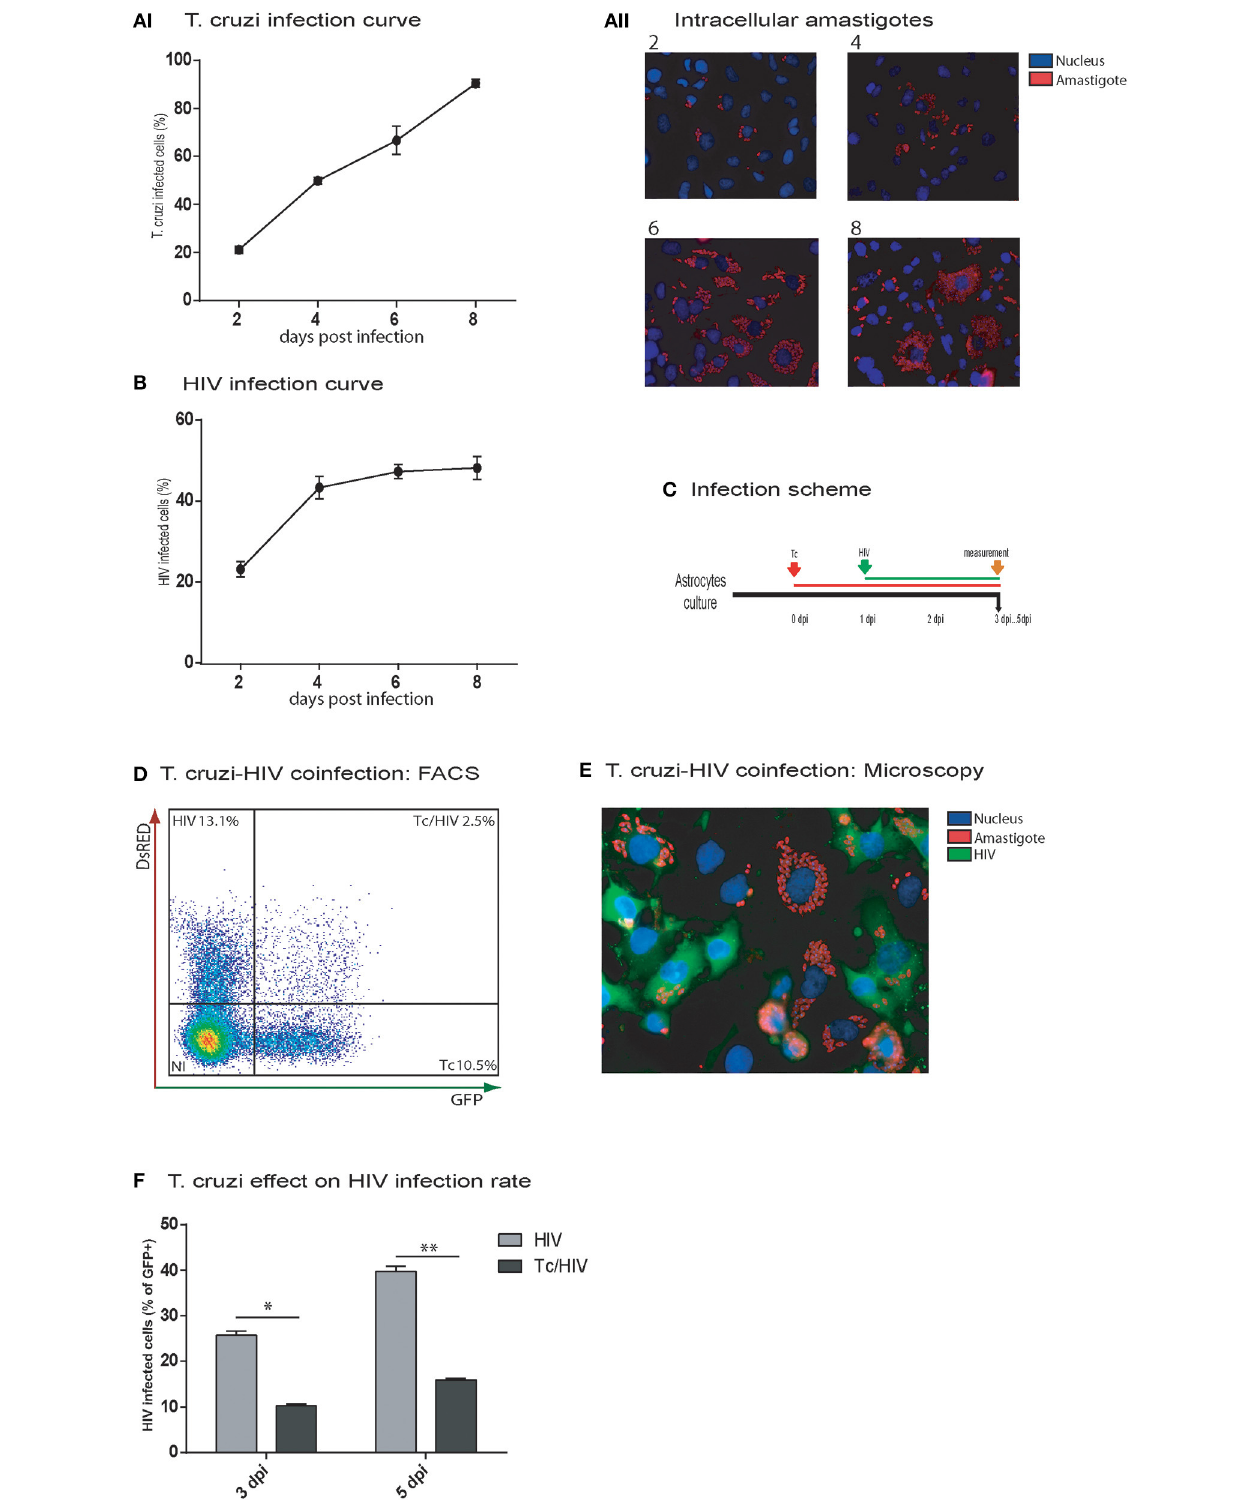
FIGURE 1 | In vitro HIV and Trypanosoma cruzi infection of astrocytes. Astrocytes were separately exposed to Tc (AI,II) , and HIV (B) , and their monoinfection curves were determined by intracellular immunostaining and cytofluorimetric analyses at the indicated time points, respectively. The frequency of Tc (AI) , the intracellular amastigotes burden (AII) and HIV (B) -infected astrocytes are represented; figures (AI,B) show mean values ± SD of two experiments performed in triplicate. Then,